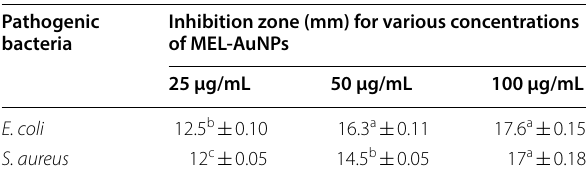
Table 1 Antibacterial activity of biosynthesized MEL- AuNPs Pathogenic bacteria